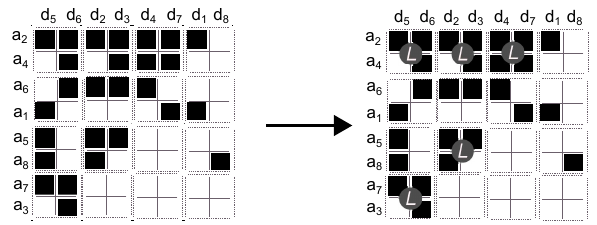
Figure 4. Step 4. Example of labelling 2 × 2 square cells. To better illustrate the result, each label is represented in a circle with the letter L .